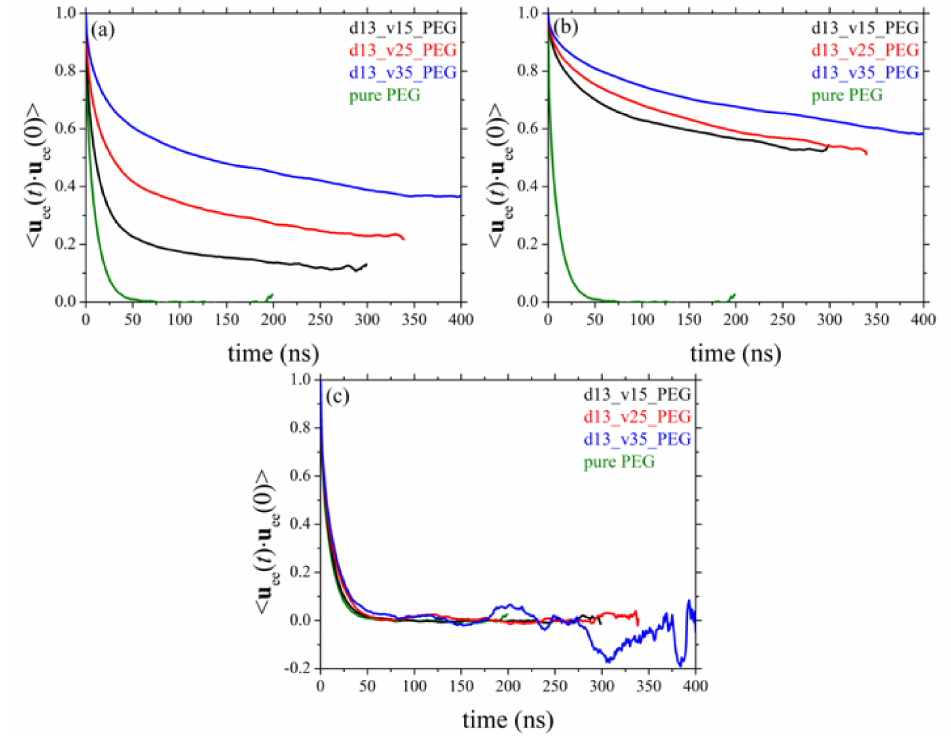
Figure 11. Same as with Figure 10 but for systems 1, 5, 6, and 7 (dependence on silica concentration). The explanation of ( a – c ) is the same as in Figure